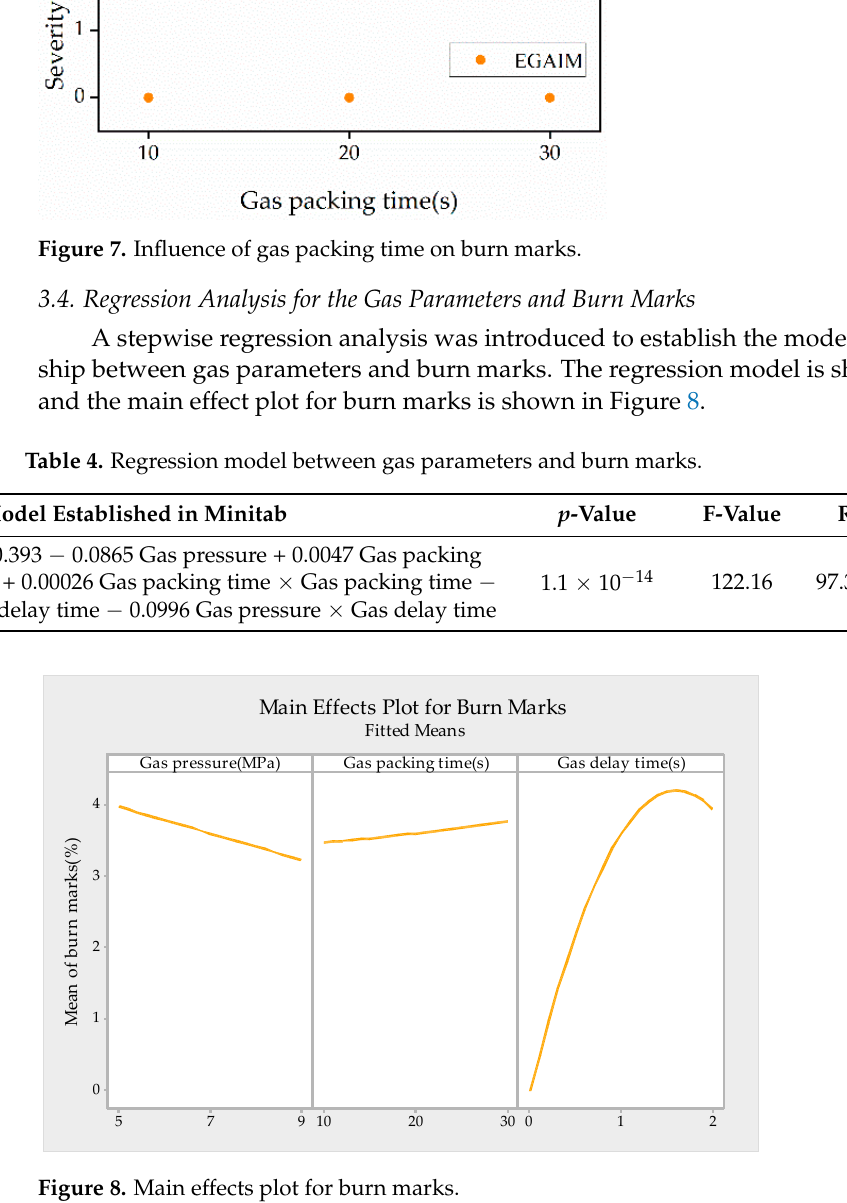
Figure 7. Influence of gas packing time on burn marks.